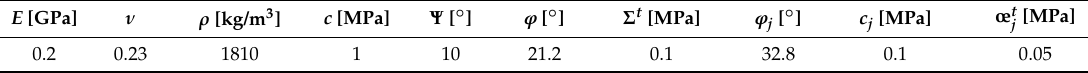
Table 6. Stress and joint constellations for tunnel model.